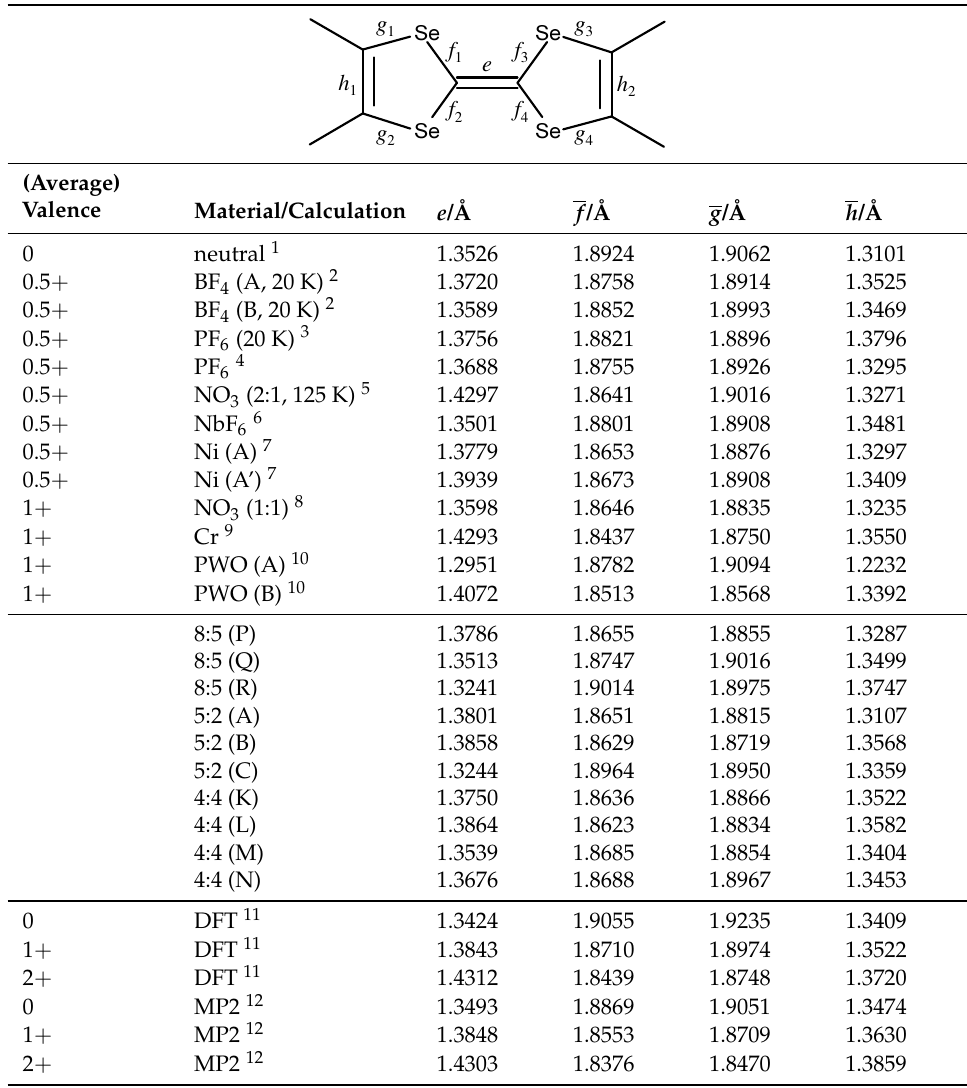
Table 2. Comparison of bond lengths in TMTSF molecules in the crystals of neutral TMTSF and some salts. Each of f , g , and h is the average such as f = ( f 1 + f 2 + f 3 + f 4 )